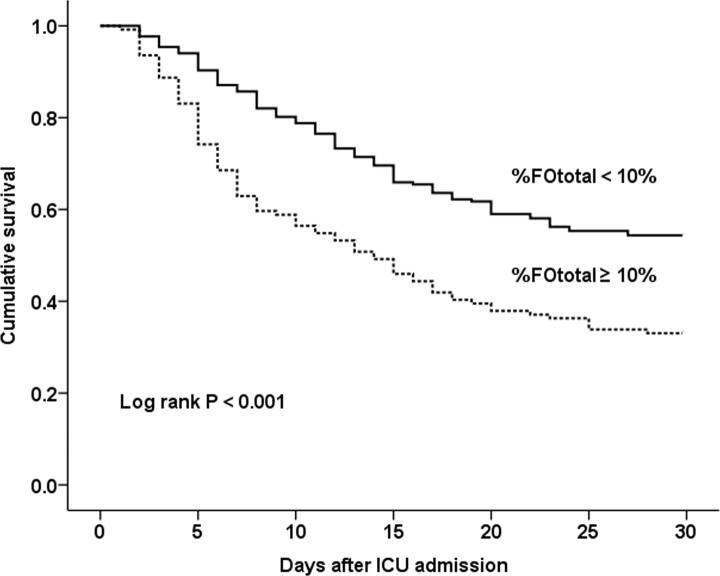
Kaplan-Meier survival estimates by fluid overload status (n = 341).There was a significant difference in survival among patients with %FOtotal ≥ 10% (n = 124) or < 10% (n = 217) (P < 0.001). %FOtotal = percentage of total fluid overload from baseline body weight from 3 days before CRRT initiation to ICU discharge. ICU = intensive care unit.